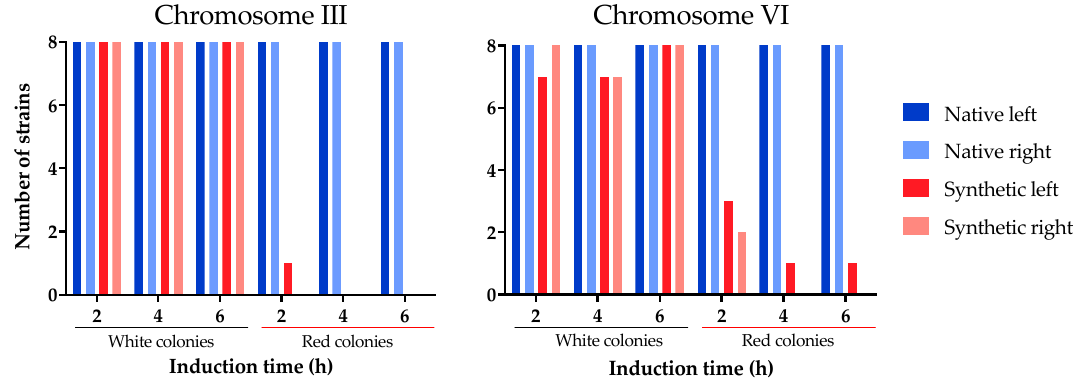
Figure A2. Detection of PCR markers on the native and synthetic chromosomes of SCRaMbLEd EW01-GAL strains. Red colonies displayed a high frequency of synthetic chromosome loss, while maintaining native chromosome integrity.